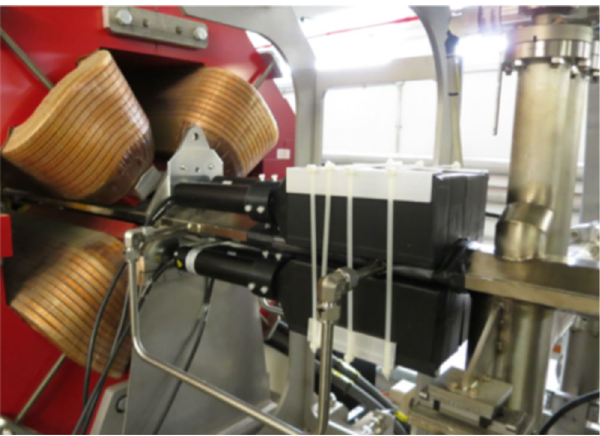
FIG. 4. The detector